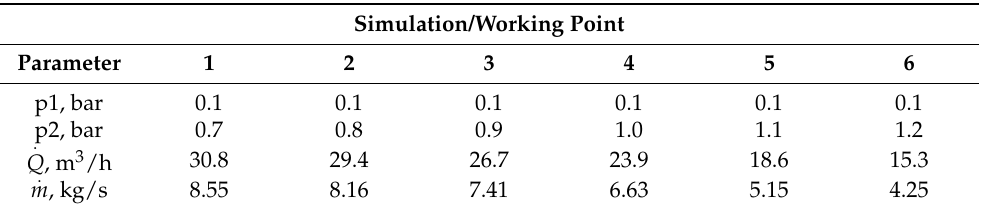
Table 1. List of parameters used in the calculation